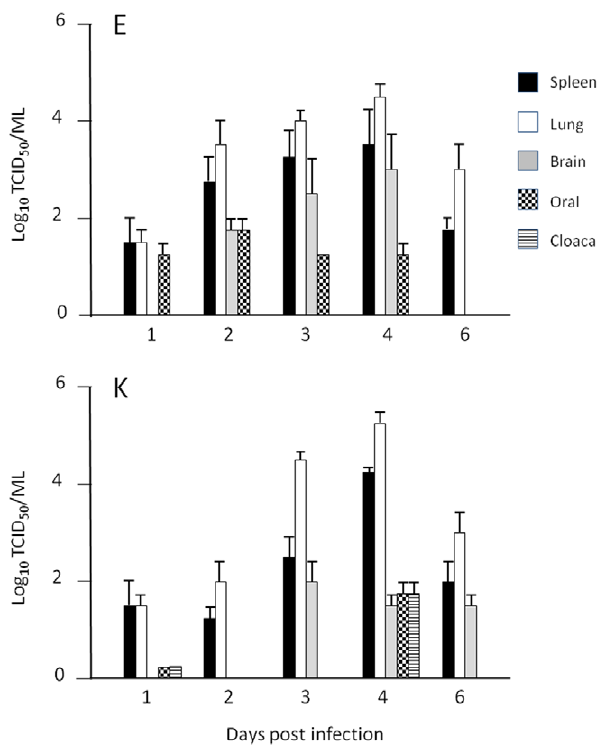
Figure 2. Virus isolation from tissues of infected chickens. Virus titers in thrombocytes, spleen, lung and brain samples, and from oropharyngeal (oral) and cloacal (cloaca) swabs collected from chickens infected with HP VN/1203/E and HP VN/1203/K at 12, 18 and 21 or 24 hours pi. All titrations were performed in Vero cells. Data show mean and SEM of 5–7 birds per time point for each virus.